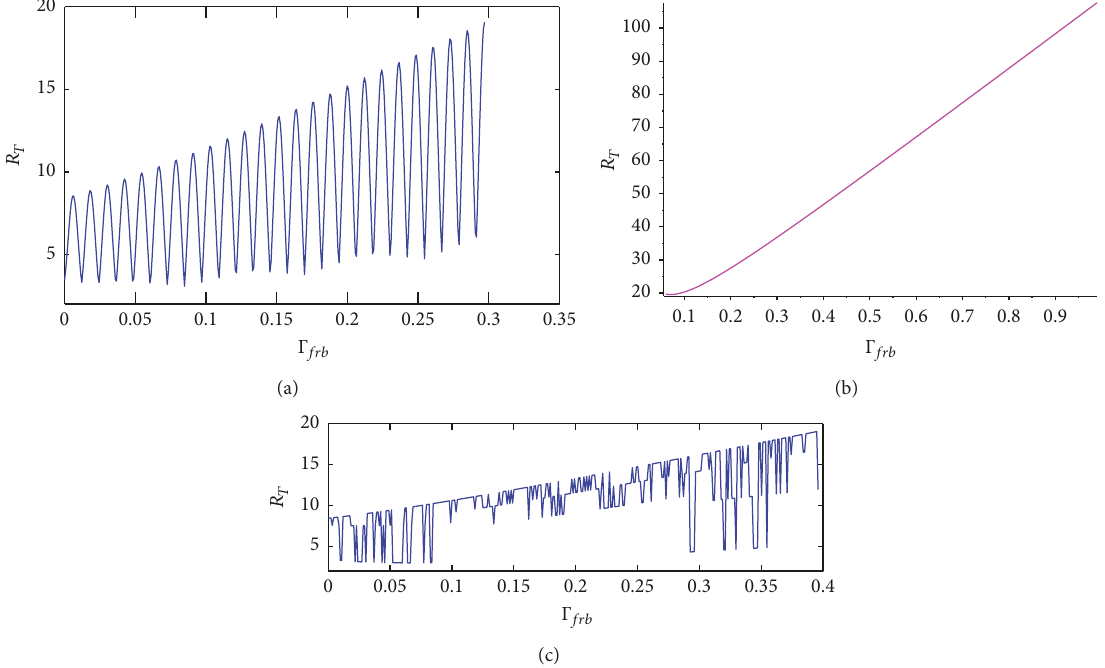
Figure 5: The effect of infection from 𝐼 𝐹 to rodents with bubonic plague on the periodic reproduction number.